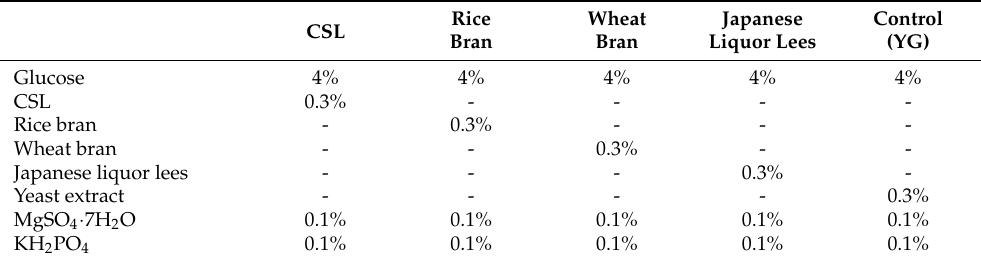
Table 1. Compositions of the media containing food industrial by-products, and the control (YG) medium. All media were adjusted to a pH of 5.5 ± 0.1.